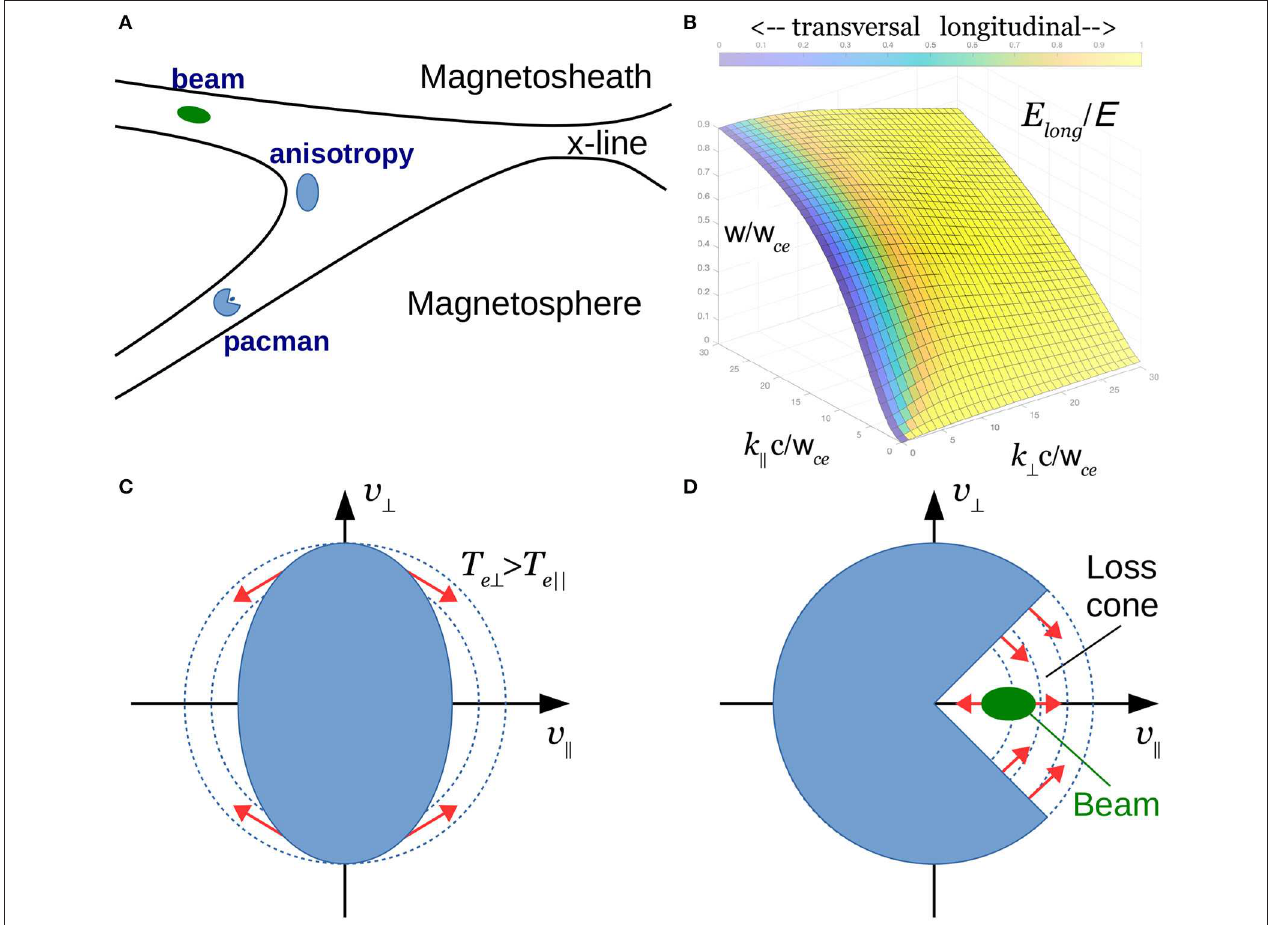
FIGURE 7 | (A) Schematic of asymmetric ( n msh > n sp , T e msh < T e sp ) magnetopause reconnection with 3 types of VDFs (anisotropy, beam, loss-cone+beam), (B) E long / E on a whistler branch predicted from cold plasma theory, (C) anisotropic distribution with T e and a cold beam. Red arrows in (C,D) illustrate pitch-angle scattering due to whistler